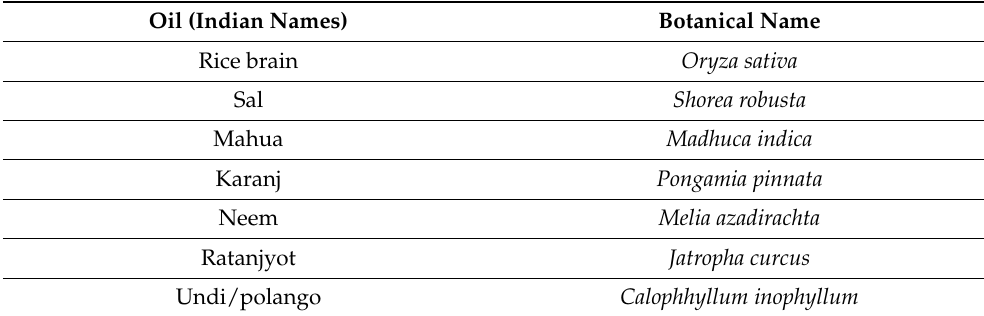
Table 1. Non-edible oil sources in India.